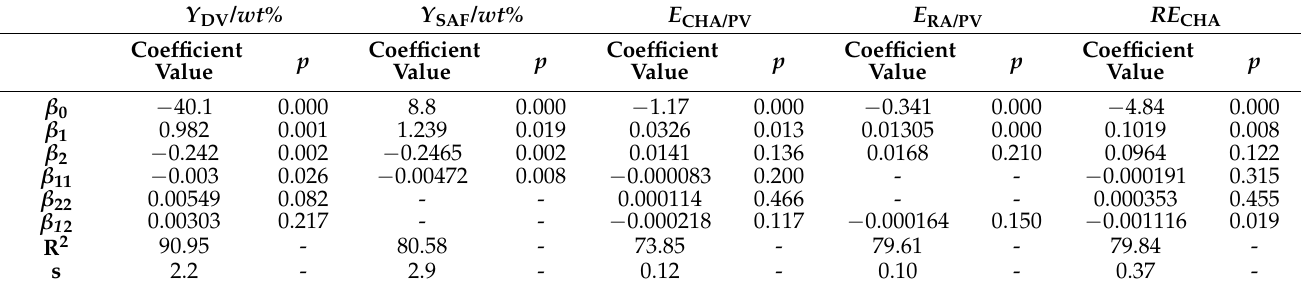
Table 2. Fitting coefficients of Equation (8) for DV and overall yields ( Y DV and Y SAF , respectively), chlorogenic and rosmarinic acid enrichment ratio in PV ( E CHA/PV , E RA/PV , respectively) and chlorogenic acid relative enrichment ratio ( RE CHA ) along with the corresponding factors of significance of the terms, p . Regression coefficients, R 2 , and standard deviation, s, are also listed for each